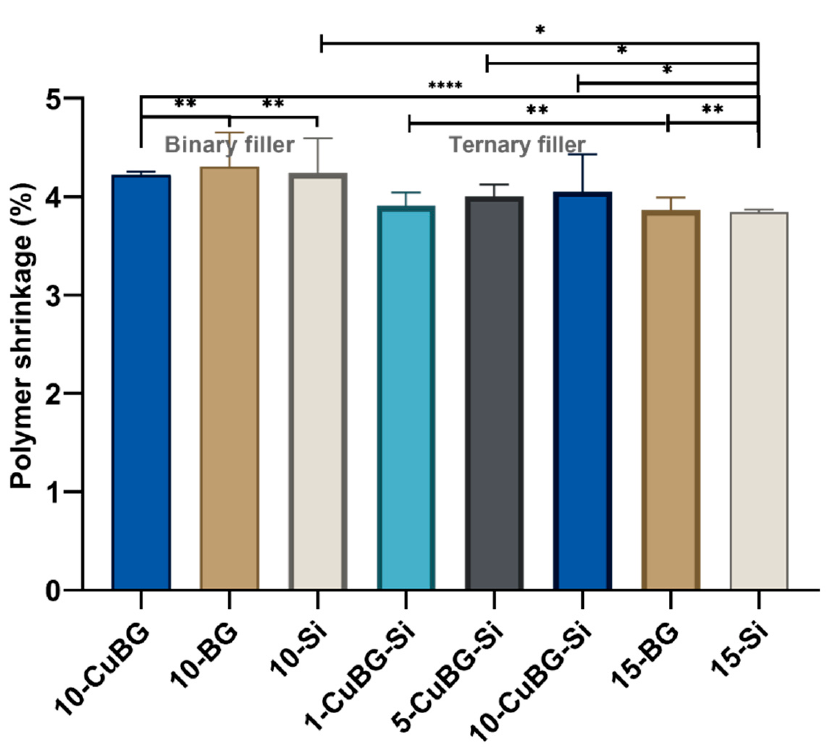
Figure 4. Polymerization shrinkage of the Binary filler and Ternary filler groups. Experimental composites were scanned using micro-CT before and after curing. Error bars represent standard deviations. A total of three samples were used per group (n = 3). Data presented as mean values with standard deviations. An asterisk indicates statistically significant differences (* p < 0.05, ** p < 0.01, **** p < 0.001).